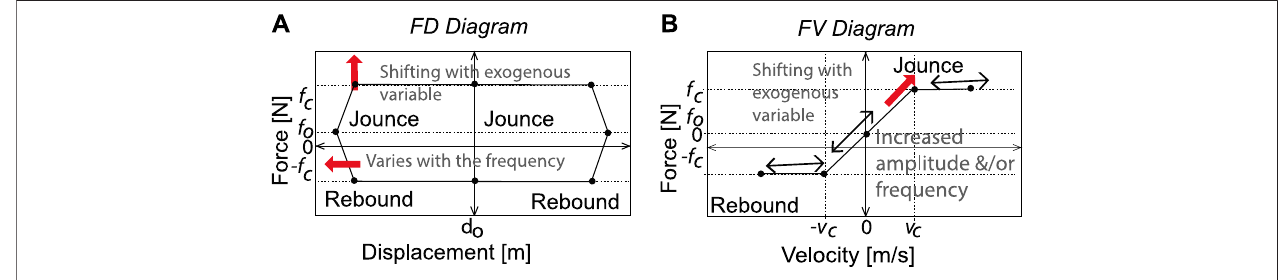
FIGURE 8 | Characteristic diagrams at ω M , Type-4 .